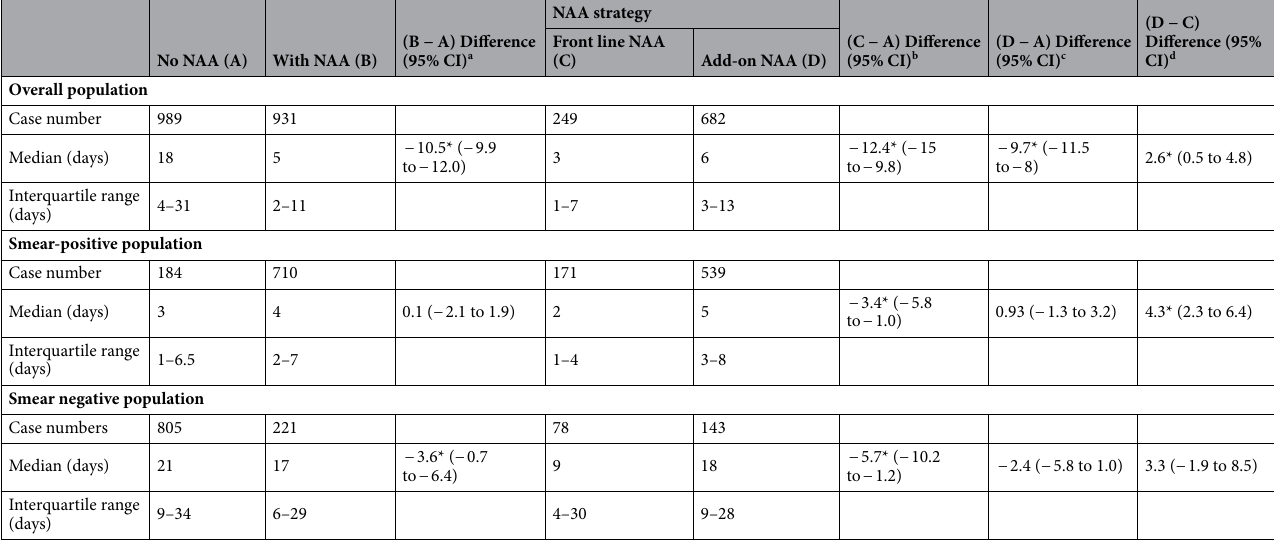
Table 4. Interval between first sputum examination and anti-tuberculous treatment among pulmonary TB patients, stratified by NAA strategy. Data are presented as n (%). NAA nucleic acid amplification, TB tuberculosis. a Comparison of mean differences between patients with and without NAA test. b Comparison of mean differences between patients with frontline NAA and no NAA test. c Comparison of mean differences between patients with add-on NAA and no NAA test. d Comparison of mean differences between patients with frontline and add-on NAA test. *p value <